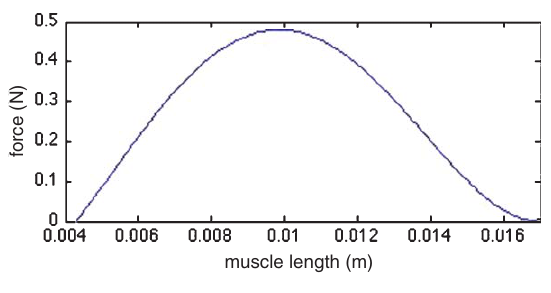
Fig. 4. A plot of the length force relationship, F l